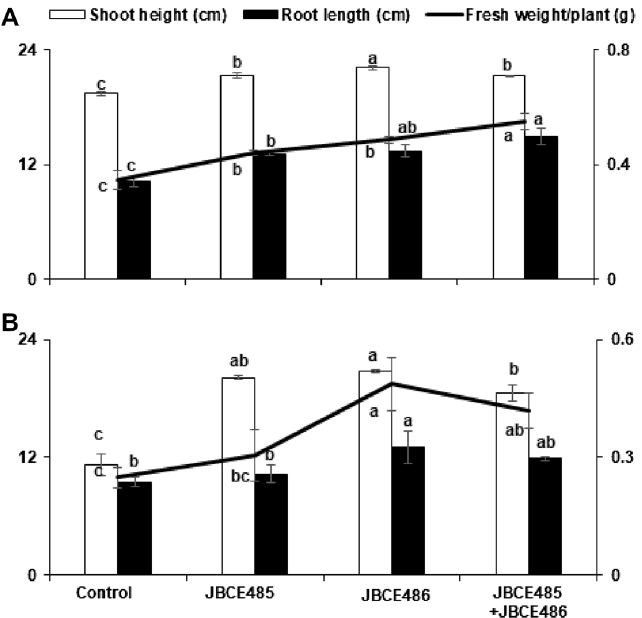
Figure 7. The effect of Pseudoxanthomonas sp. JBCE485 and Variovorax paradoxus JBCE486 on the growth of chive under salt stress conditions. Seeds of chive were treated with 1 × 10 7 CFU/mL cells of each bacterium JBCE485 and JBCE486, and their mixture. Seeds were grown on horticultural nursery soil soaked with tap water ( A ) with or ( B ) without 175 mM NaCl (soil/water, 2:1 v/v). The left Y-axis indicates shoot height (cm) and root length (cm), and the right Y-axis indicates fresh weight of plants (g). Growth was recorded at 4 and 6 weeks after cultivation in soil without or with salt, respectively. The data are represented as mean ± standard deviation and bars with the same letter do not differ significantly at P = 0.05.